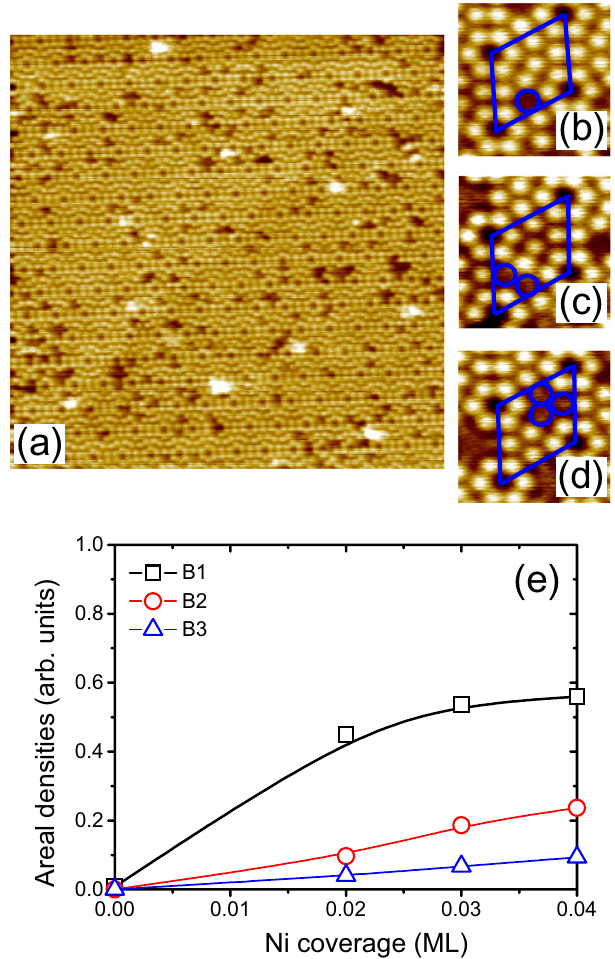
Figure 2. ( a ) STM images of 0.02 ML Ni/Si(111). Enhanced STM images showing ( b ) B1, ( c ) B2, and ( d ) B3. The image sizes are 50 × 50 nm 2 for ( a ), and 1.0 × 1.0 nm 2 for ( b – d ). ( e ) Statistics for the areal densities of B1, B2, and B3 calculated from STM images in 50 × 50 nm 2 area for Ni adatoms on